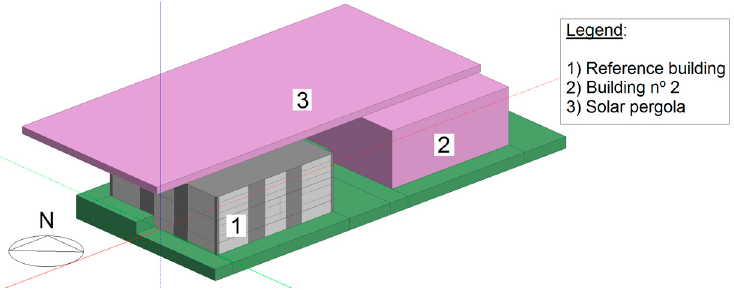
Figure 2. Virtual model of the entire facility with roof-integrated solar pergola. Solar pergola total